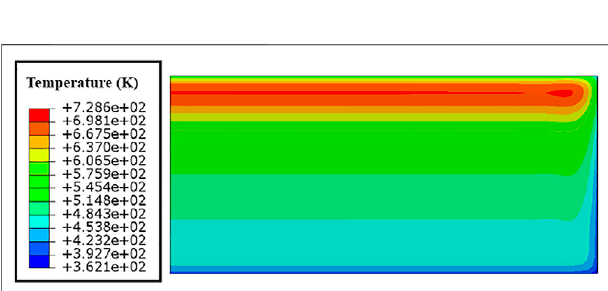
FIGURE 11 | Temperature distribution of the fuel meat after 120 days